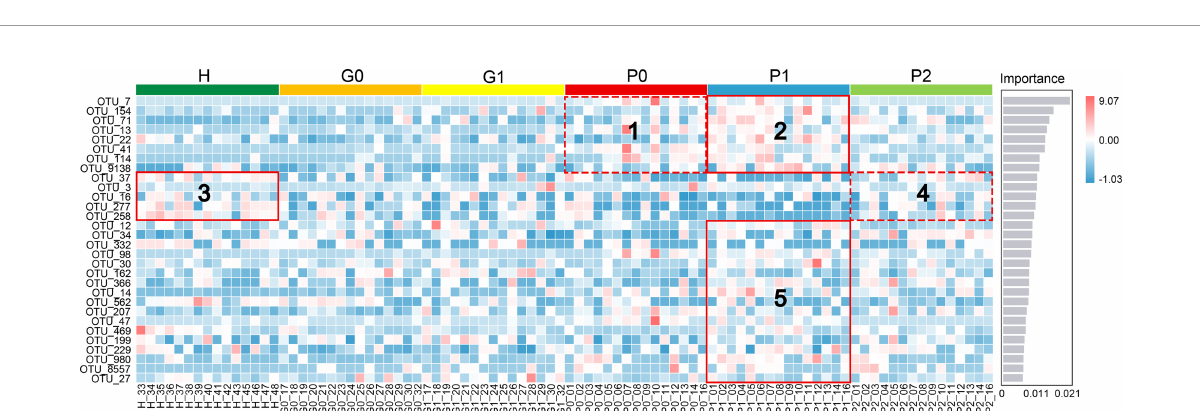
FIGURE 3 | Differential species and ROC analysis. (A) Comparison of the relative abundance of bacteria by species between the H and P0 groups at baseline. P < 0.05 by Welch ’ s t-test. (B) Receiver operating characteristic (ROC) analysis of distinguishing group H from group P0 using detected species assessed by the area under the curve (AUC). (C) ROC curve for the logistic regression model of combined diagnosis by the fi ve detected